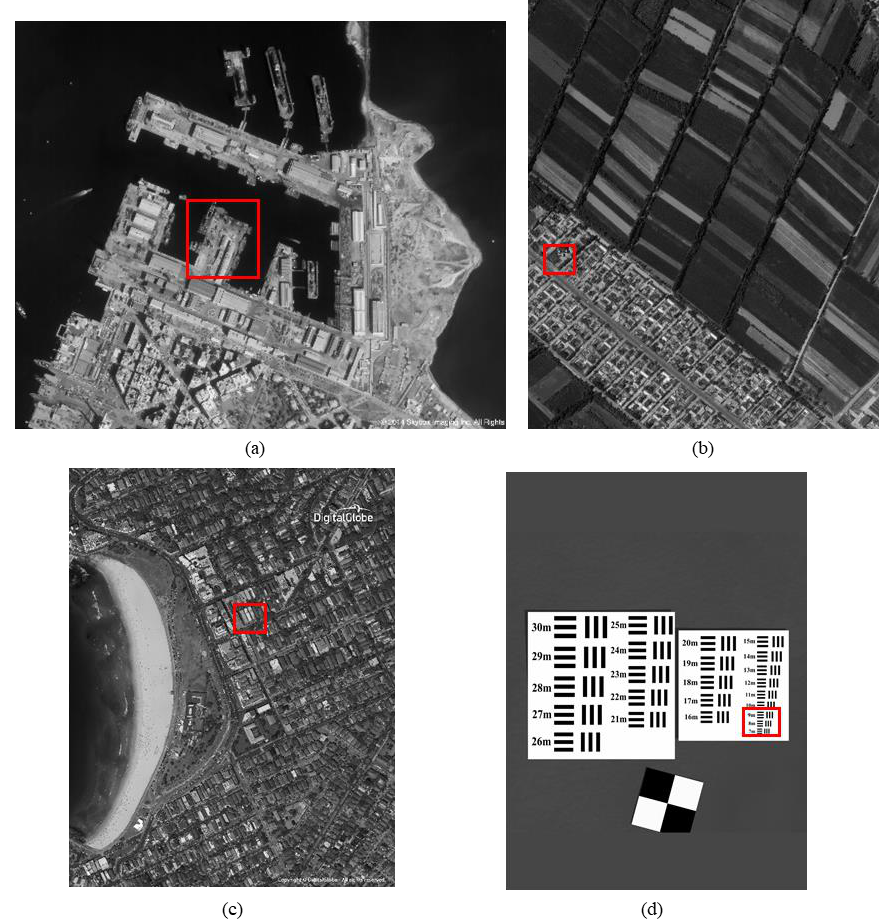
Figure 6. The original high-resolution images: ( a ) seashore remote-sensing image, the chosen area is an offshore structure in an Egyptian port; ( b ) farmland remote-sensing image, the selected area is the crops and houses in Xinjiang, China; ( c ) city remote-sensing image, the selected area is buildings in Sydney; ( d ) target image, the selected area is minimum resolvable line pairs.